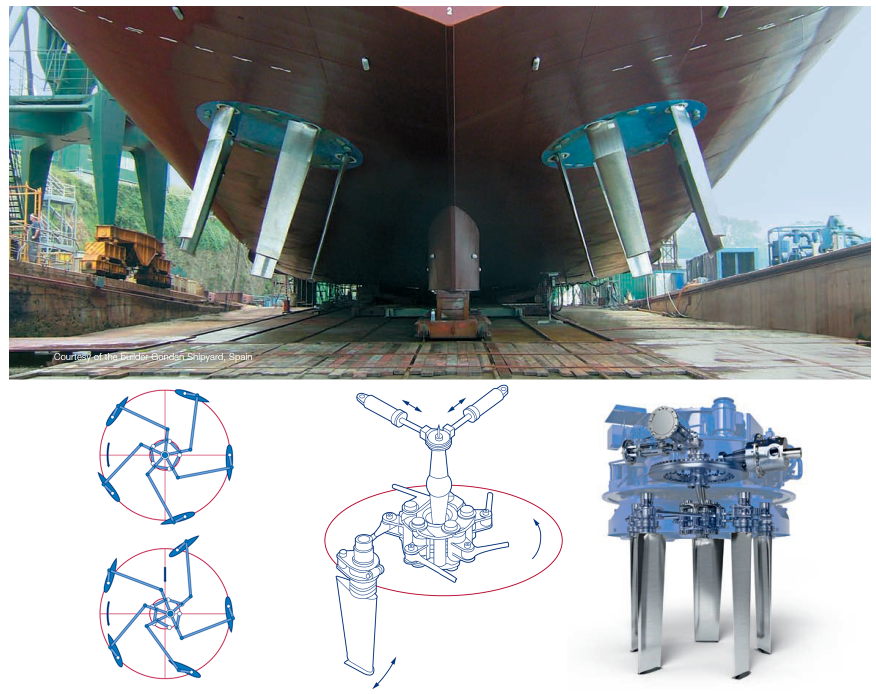
Figure 2. General overview of voith installation on a vessel on the top and some sketch of the